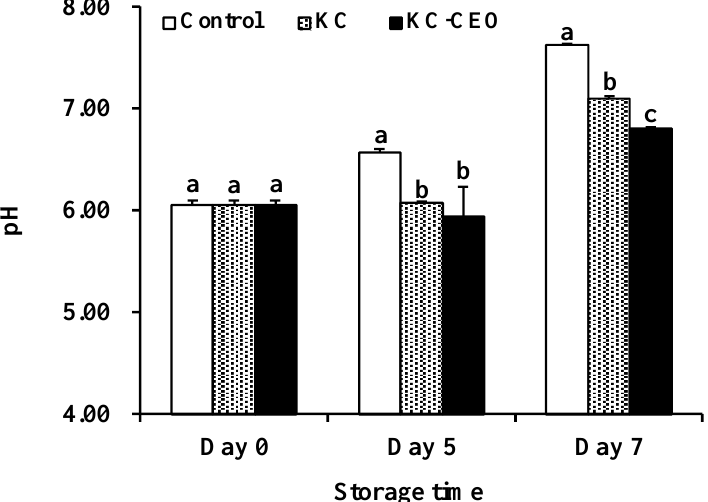
Figure 5. Impact of KC-based coatings on the pH value of pork meat during refrigerated storage (4 ◦ C). KC, kappa-carrageenan; CEO, cinnamon essential oil. Different letters for data points on each day represent significant differences ( p < 0.05).